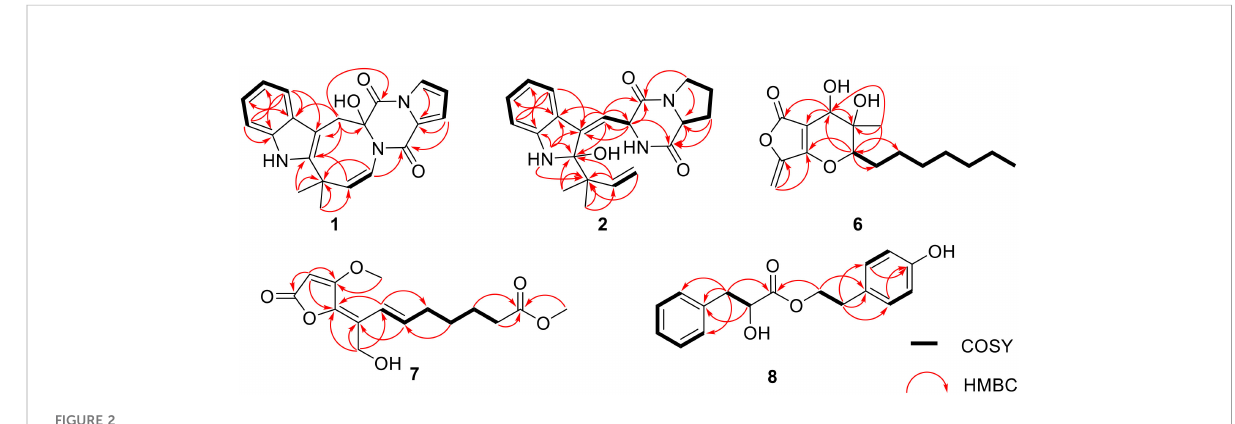
FIGURE 2 Key correlations of compounds 1 , 2 , and 6 − 8